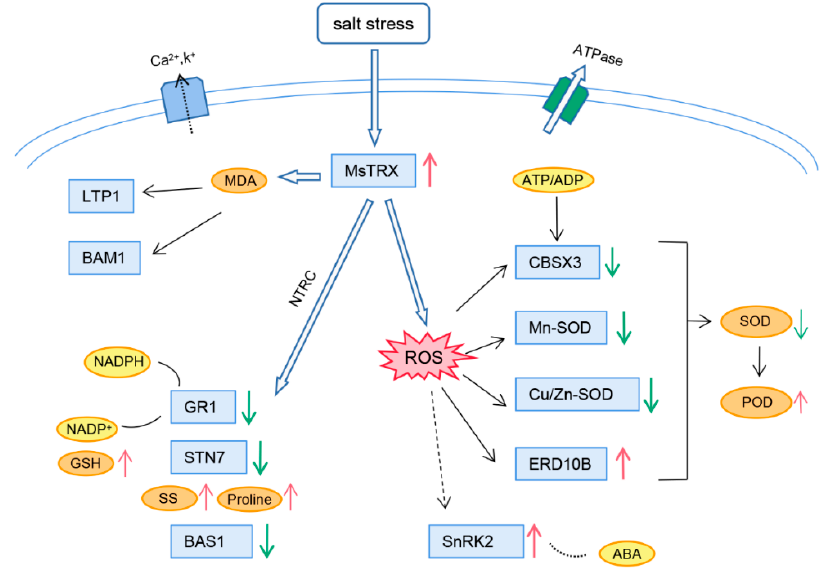
Figure 5. Possible molecular mechanisms of MsTRX in response to salt stress. ABA: abscisic acid. ADP: adenosine diphosphate. ATP: adenosine triphosphate. BAM1: beta-amylase 1. BAS1: phyB activation-tagged suppressor 1. CBSX3: candidate signal molecules/sensor relay proteins. Cu/Zn- SOD: superoxide dismutase [Cu-Zn]. ERD10B: dehydrin DHN1-like. GR1: protein gamma response 1. GSH: reduced glutathione. LTP1: lipid-transfer protein 1. MDA: malondialdehyde. Mn-SOD: super- oxide dismutase [Mn]. NADP: nicotinamide adenine dinucleotide phosphate. NADPH: nicotinamide adenine dinucleotide phosphate. NTRC: NADP-thioredoxin reductases (NTR) with a distinctive ex- tension of the TRX domain. POD: peroxidase. ROS: reactive oxygen species. SnRK2: serine/threonine- protein kinase. SOD: superoxide dismutase. SS: soluble sugar. STN7: serine/threonine-protein kinase that phosphorylates LHCII protein 7. The red arrow indicates the upregulation of stress-response genes or the increase in physiological indicators. The green arrow indicates the downregulation of stress-response genes or the decrease in physiological indicators. Dotted lines indicate the possible adjustment